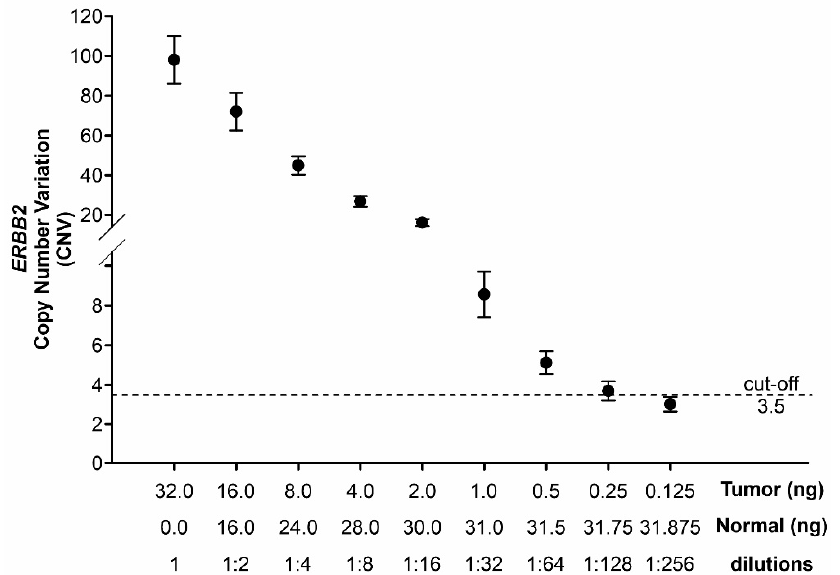
Figure 3. ERBB2 CNV values in serial dilutions of tumor DNA with increasing amount of its normal counterpart. For each dilution, the absolute quantity (ng) of tumor and normal DNA as well as dilutions were reported. The positivity for ERBB2 amplification was detected up to a 1:64 dilution.